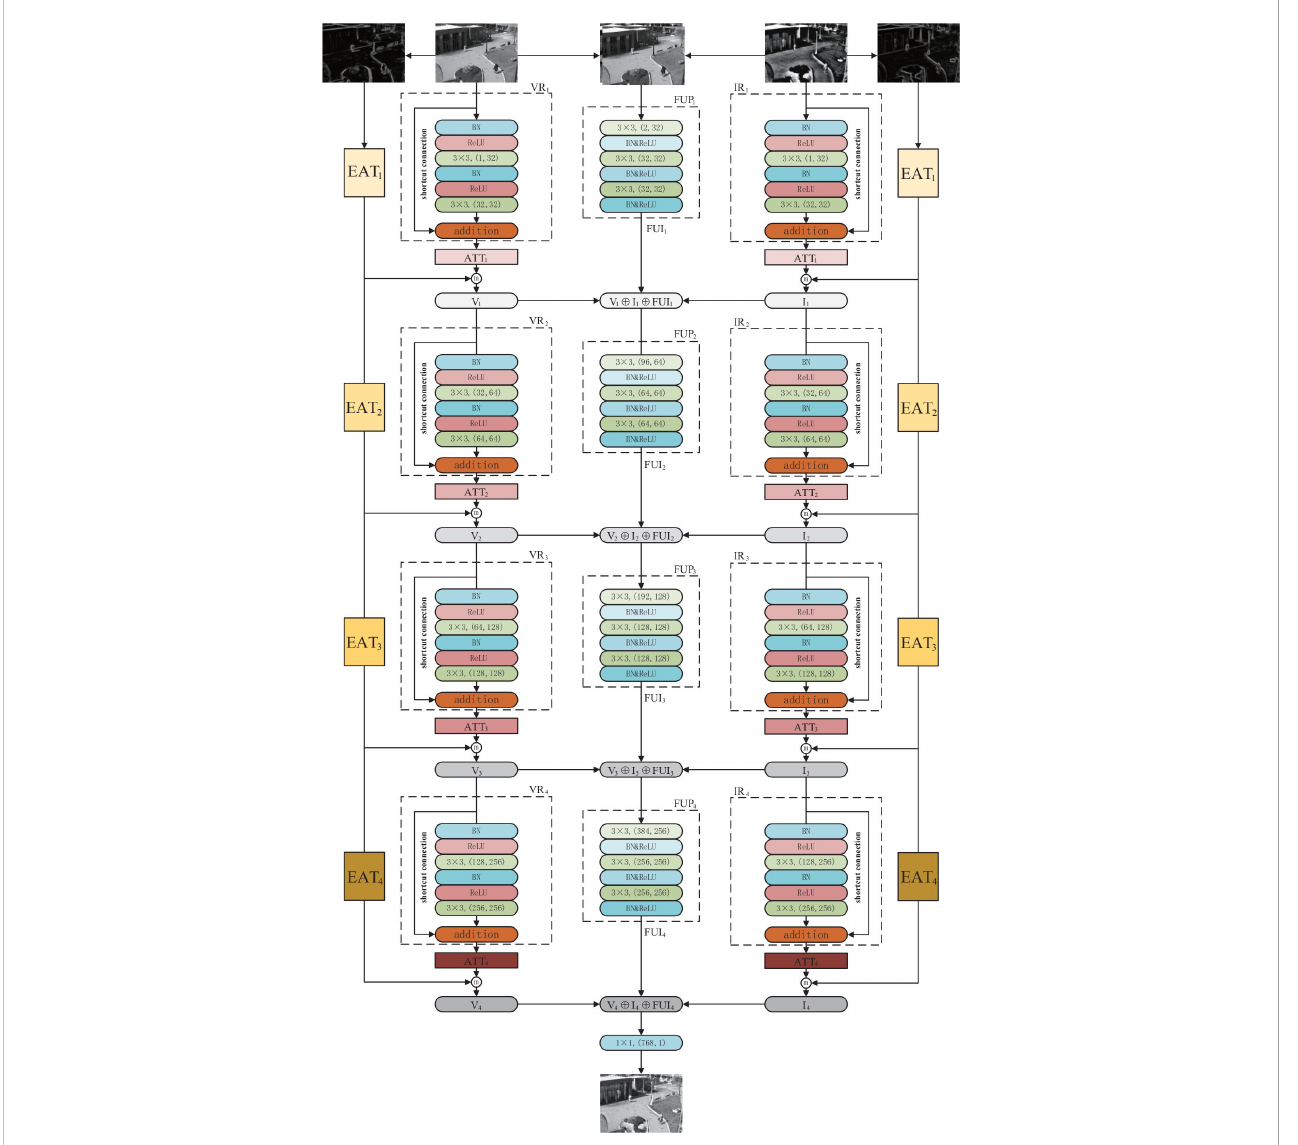
FIGURE 5 The structure of RADFNet. ‘ ATT 1 − 4 ’ denote the multiscale channel attention module and ‘ EAT 1 − 4 ’ denote the edge attention module. ‘ 3 × 3,(1, 32) ’ means the kernel size is 3 × 3, input channel is 1 and output channel is 32 in a convolutional